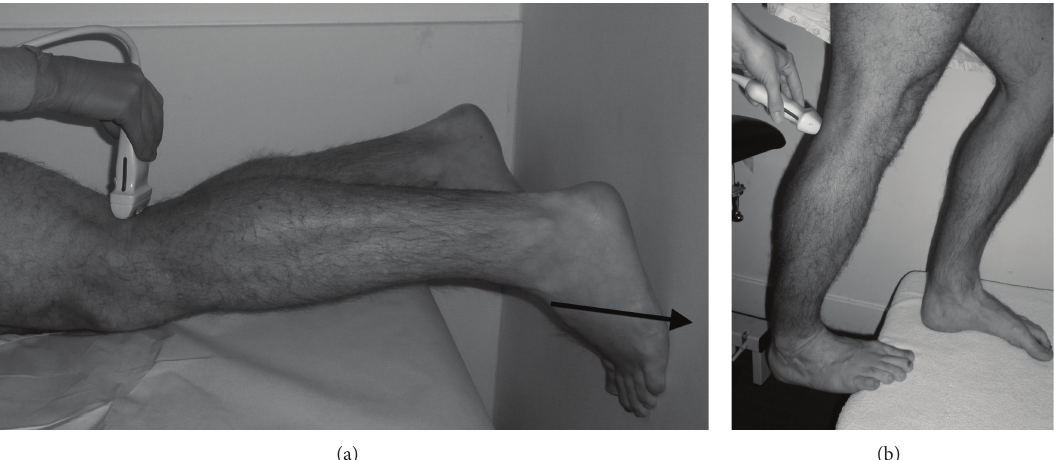
Figure 1: (a) Patient prone and pushing against a wall (in the direction of the arrow) at 25% maximum plantarflexion force. (b) Patient erect and plantarflexing against full body weight.